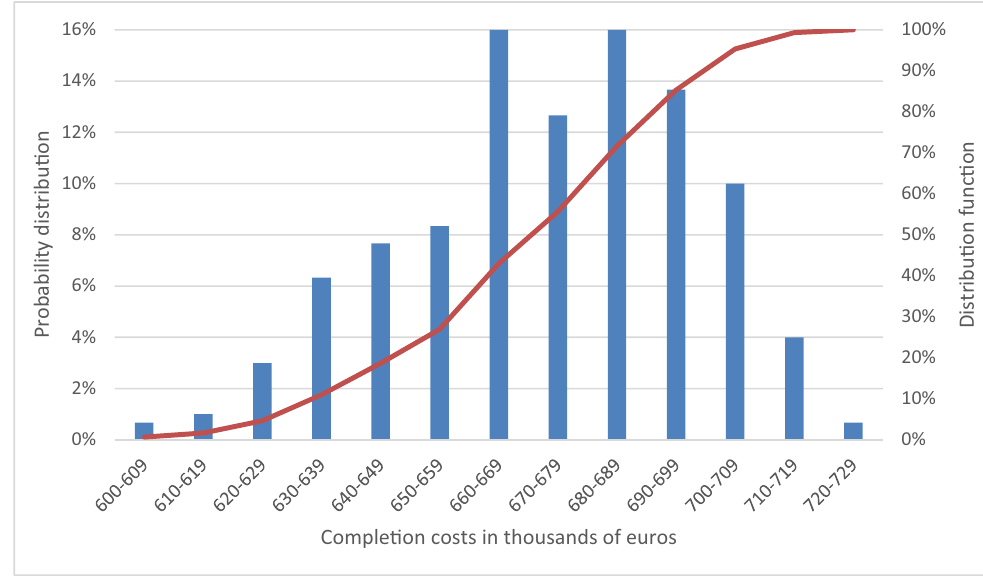
Figure 8: Probability distribution and distribution function for project completion